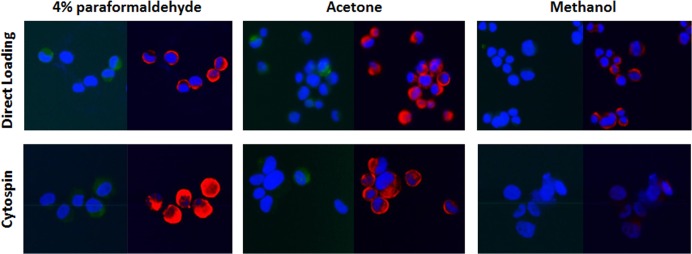
Immunostaining of EpCAM and Vimentin for cultured cells after different cell transfer and fixation methods.EpCAM was shown as green signals and Vimentin was shown as red signals. Exposure time and magnification of images were the same for each method. Based on the same fixation, EpCAM signals by direct transfer were stronger than those by Cytospin. In addition, the morphology of cells was flattened after cytospin. Based on the same transfer method, paraformaldehyde provided the brightest signals and methanol provided the weakest and uneven signals.